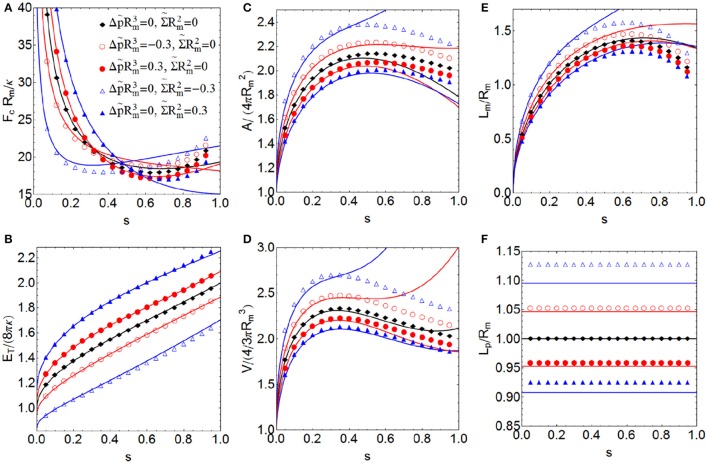
More relevant properties of a constricted vesicle with zero spontaneous curvature C0 = 0 at all stages of constriction for different values of the dilatation invariant products Σ~Rm2 and Δp~Rm3, which are associated with surface tension and pressure, respectively. Total energy ET in units of 8πκ (A), constriction force Fc in units of Rm/κ (B), total area A in units of 4πRm2
(C), total volume V in units of 4/3πRm3
(D), constriction length Lm in units of Rm
(E) and polar distance Lp in units of Rm
(F). Comparison between the exact numerical results (points) with the approximate analytical expressions obtained up to sixth order of perturbation (lines).